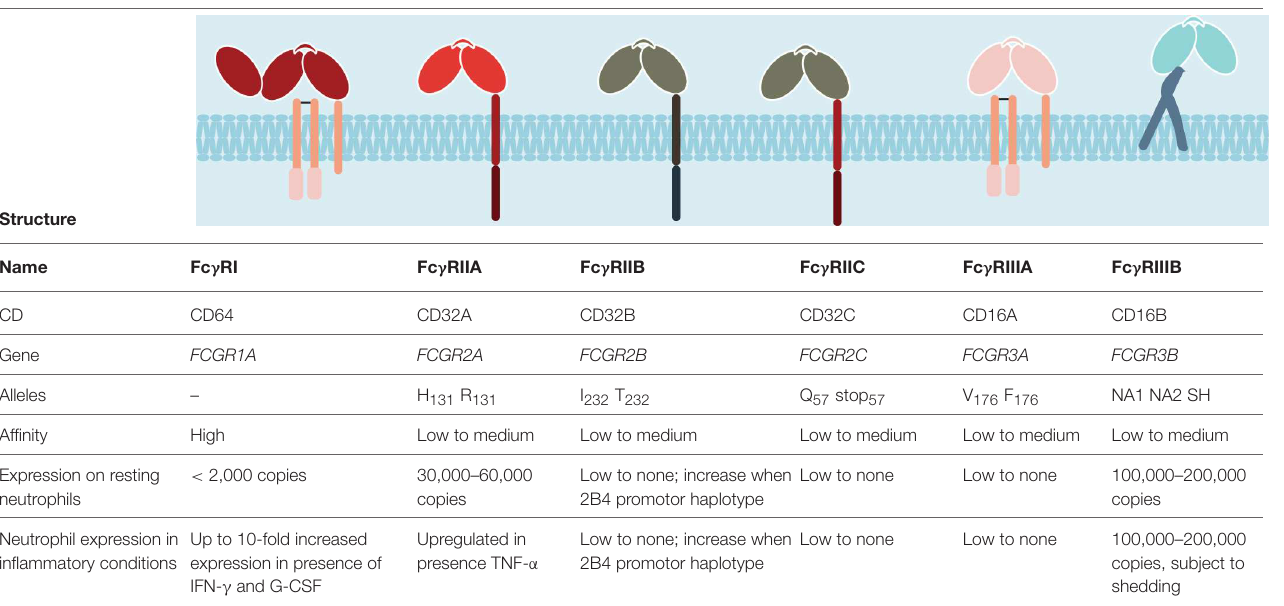
TABLE 1 | Classical Fc γ Rs and their expression on